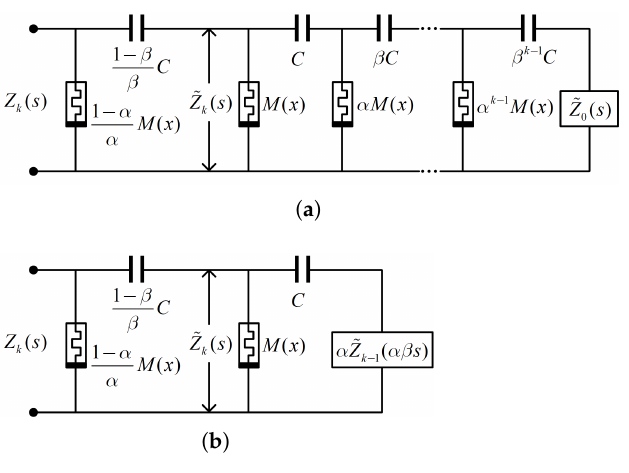
Figure 3. Chain-scaling fracmemristor circuit: ( a ) circuit configuration; ( b ) iterating